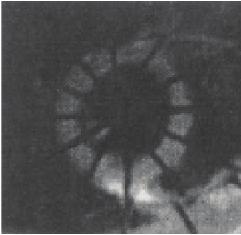
Figure 3: Radially tagged cardiac MRI taken from